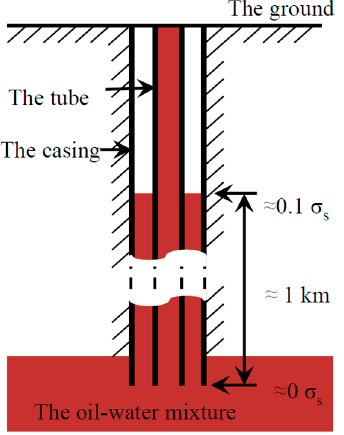
Figure 11. The initial stresses that different parts of the downhole tube or casing suffer.